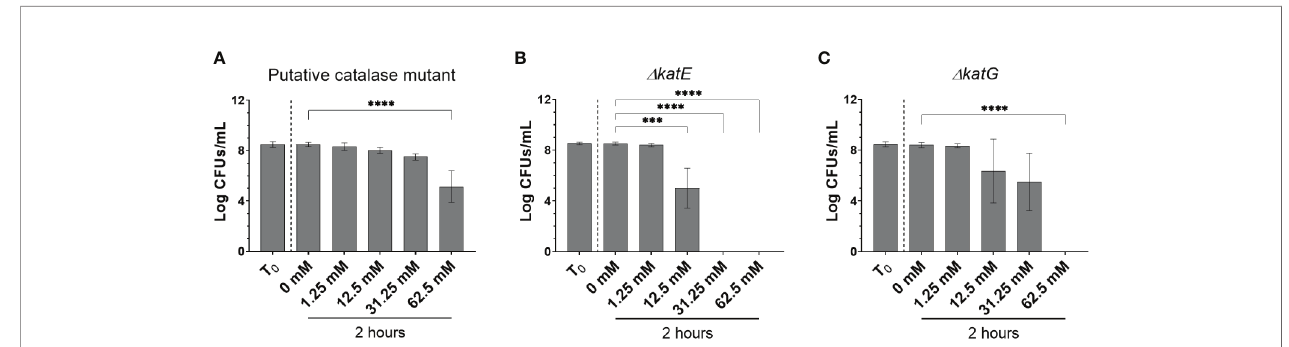
FIGURE 4 | Tolerance of S. Typhimurium catalase mutant bio fi lms to H 2 O 2 . (A – C) Bio fi lm aggregates were challenge with H 2 O 2 at their planktonic MIC (1.25 mM) and escalating challenge concentrations of 12.5 mM, 31.25 mM, and 62.5 mM H 2 O 2 to determine the limit of tolerance. Values were selected to represent a 0×, 1×, 10×, 25×, or 50× increase from the experimentally-determined MIC. Signi fi cance was determined by one-way ANOVA and Dunnett multiple comparison correction (***p < 0.0005; ****p < 0.0001). Each experiment was conducted in triplicate and the data represents the mean of three independent experiments. The error bars indicate SD.